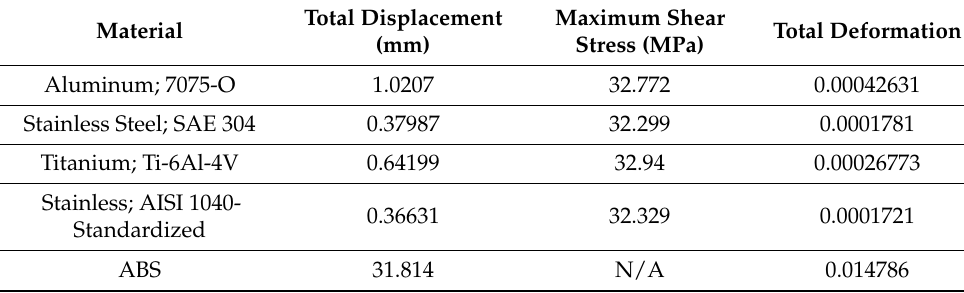
Table 3. Numerical results of 7 DOF prosthesis with different materials.